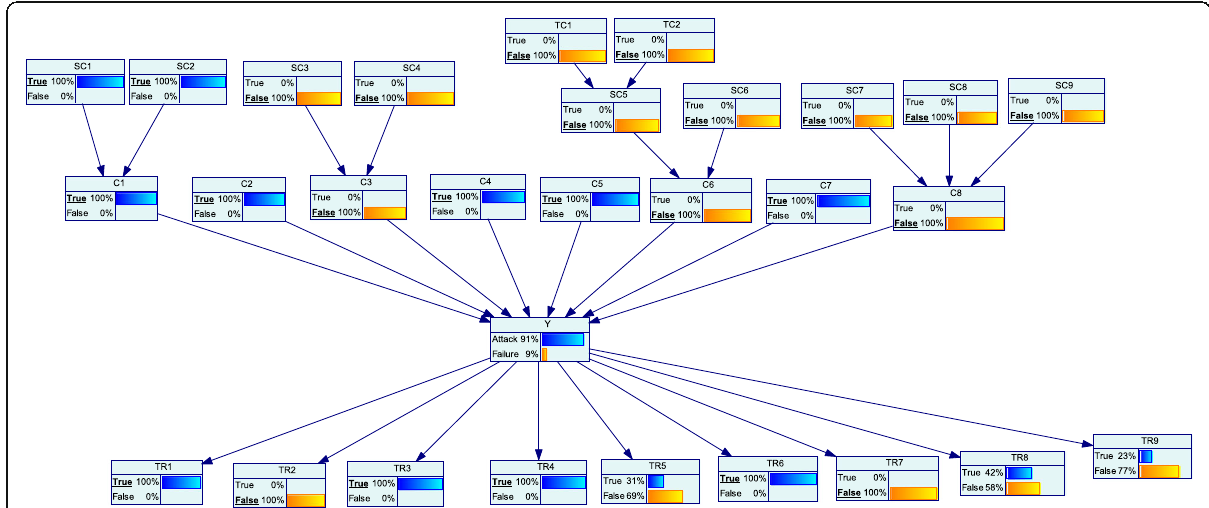
Fig. 9 Constructed BN Model – Second Illustrative Scenario